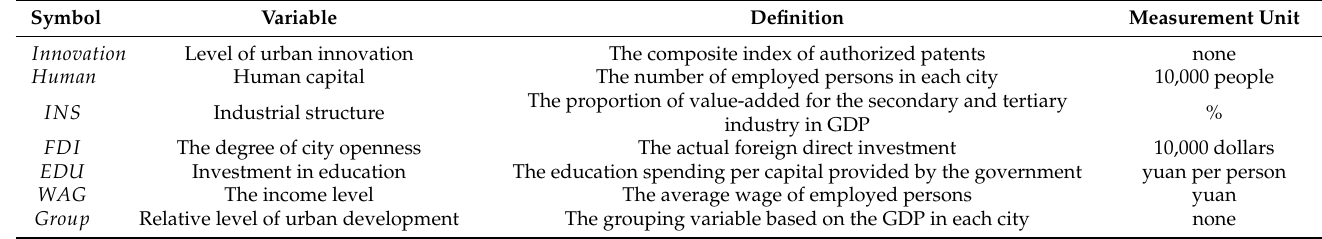
Table 1. Description of the variables used in the study.